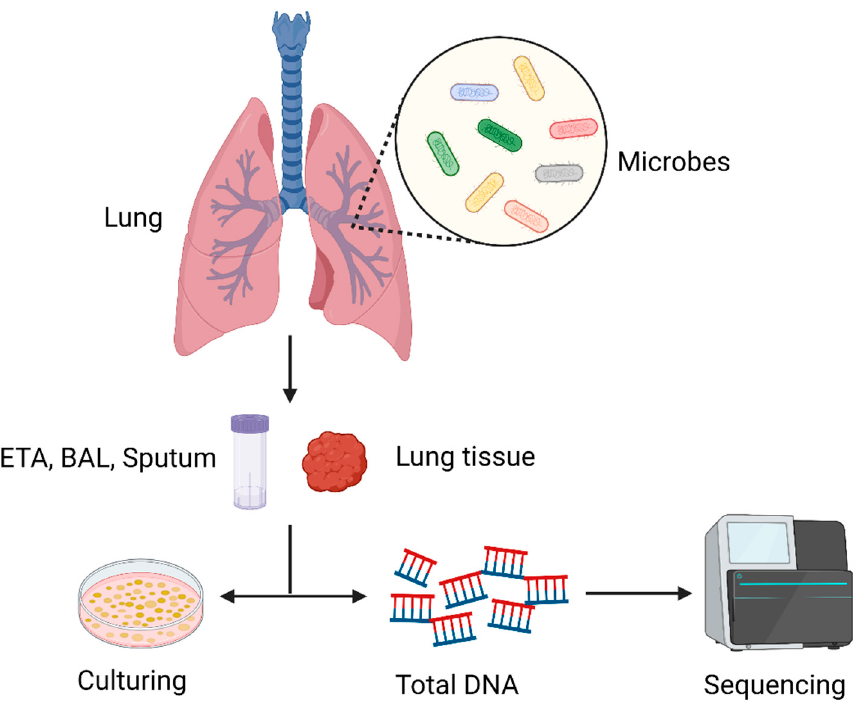
Figure 1. Schematic diagram of the process of lung microbiome detection: First, a qualified sample needs to be collected. Common samples include endotracheal aspirates (ETAs), bronchoalveolar lavage (BAL), and sputum, but in the case of diagnosed lung cancer, lung biopsy tissue can also be used as the sample to be detected. Next, there are two main types of analysis methods: culture-based and culture-independent methods; the former refers to the isolation of microbes by selecting suitable media and culturing them in a suitable environment, while the latter refers to the extraction of DNA from microbes for sequencing to obtain microbial profiles.